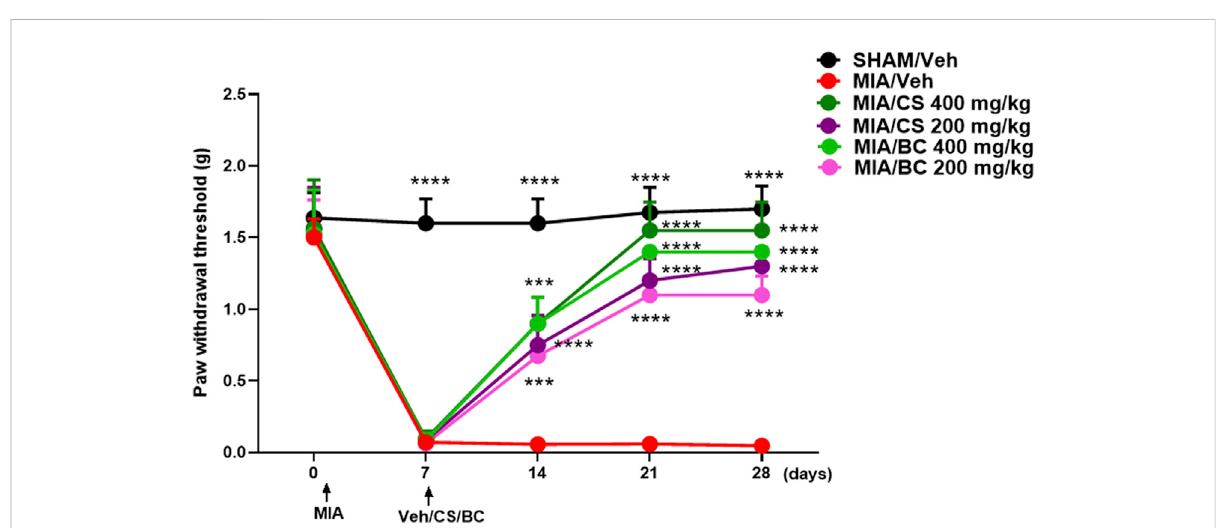
FIGURE 2 Effect of daily administration with CS or BC (at the doses of 200 and 400 mg/kg) or vehicle (saline) on the mechanical allodynia in MIA-injected